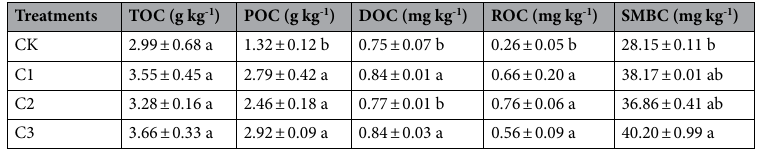
Table 1. Organic carbon components in the mixed soils with different proportions of soft rock and sand. Mean ± SD, different lowercase letters in the same column indicate 5% difference between treatments. CK, the volume ratio of soft rock to sand is 0:1; C1, the volume ratio of soft rock to sand is 1:5; C2, the volume ratio of soft rock to sand is 1:2; C3, the volume ratio of soft rock to sand is 1:1; TOC soil total organic carbon; POC particulate organic carbon; DOC dissolved organic carbon; ROC oxidized organic carbon; SMBC soil microbial biomass carbon.